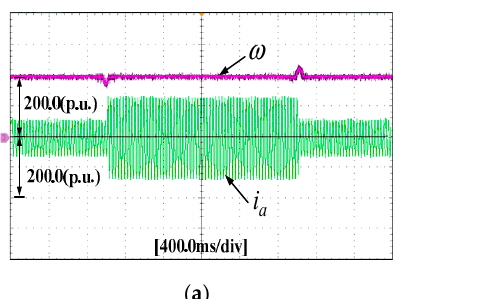
Figure 11. Experimental platform of IPMSM drive.